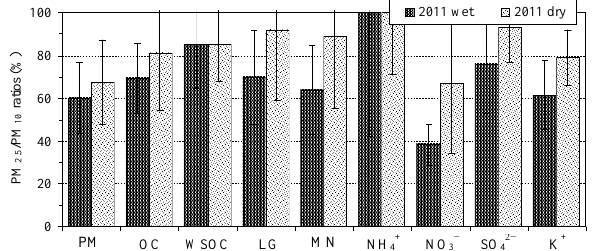
Fig. 2. Mean concentration ratios (%) of selected aerosol compo- nents or species in PM 2 . 5 to those in PM 10 during the 2011 wet and dry season campaigns in